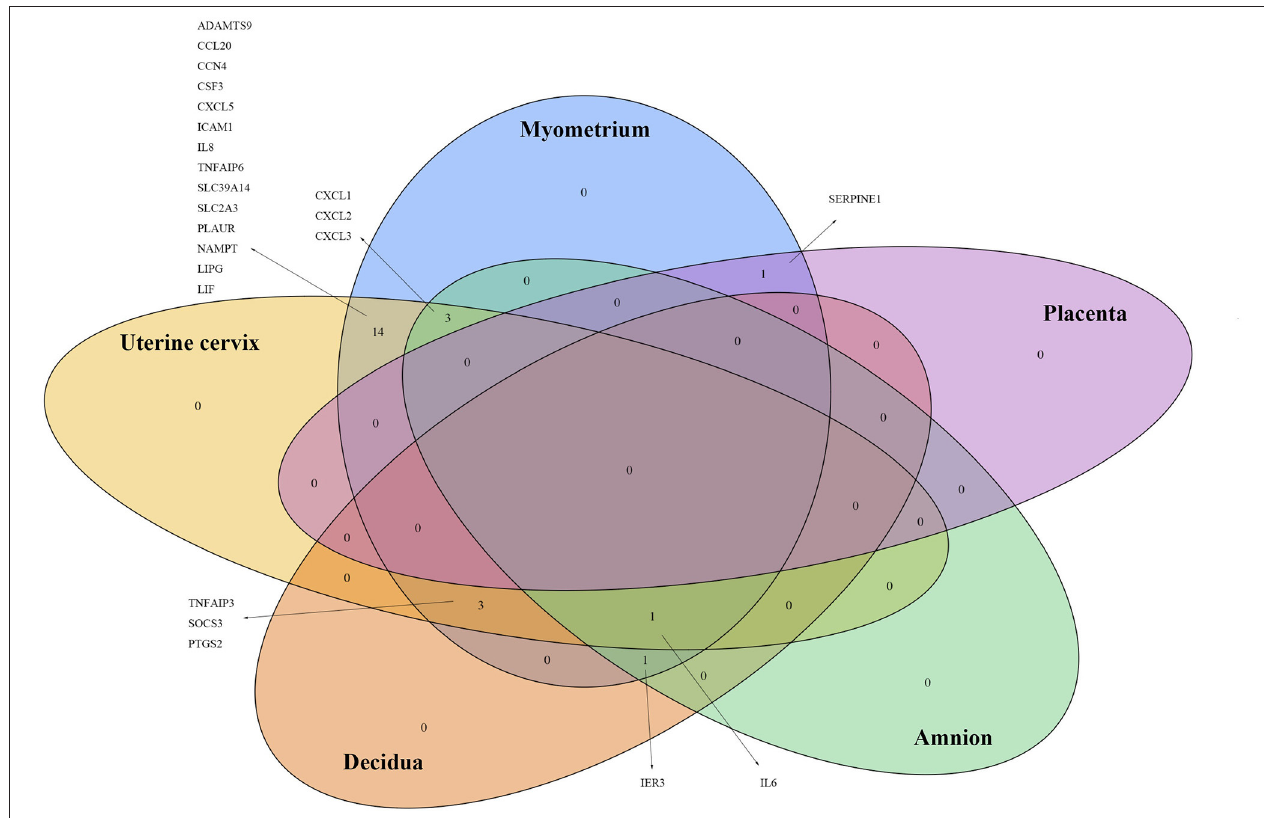
FIGURE 4 | Genes of which the expressions were reported significantly changed in more than one tissue by two or more